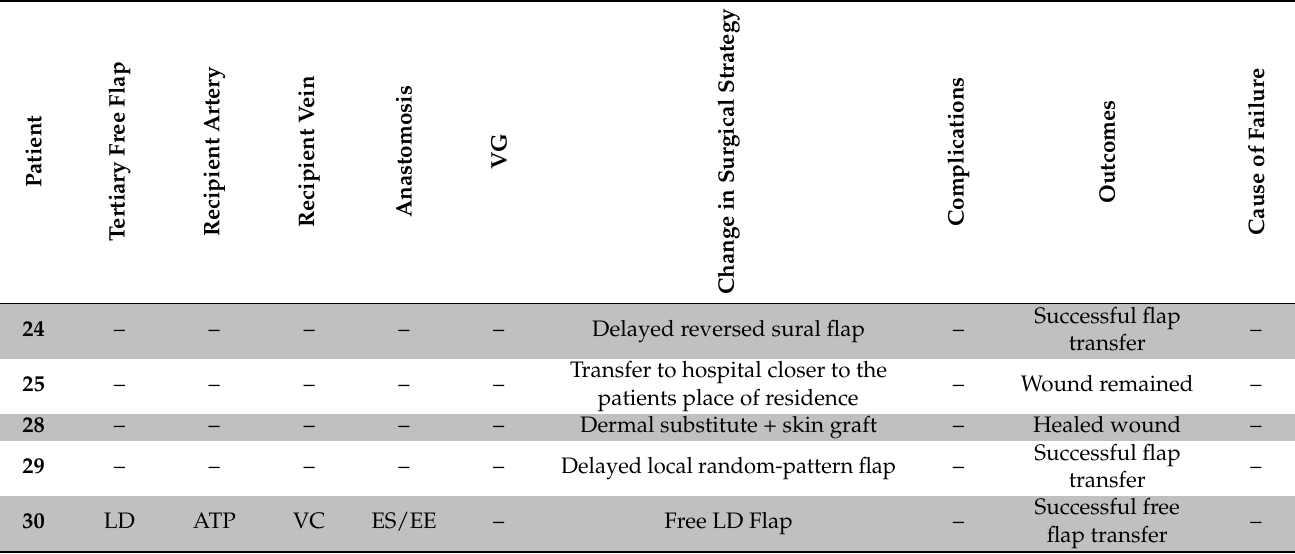
Table 4. Surgical strategy after failure of the secondary